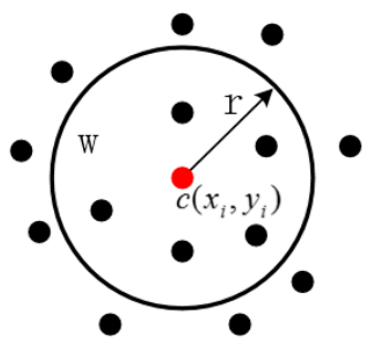
Figure 2. Gaussian kernel function estimation method.